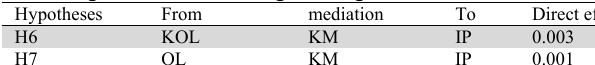
Mediating Effect of knowledge management